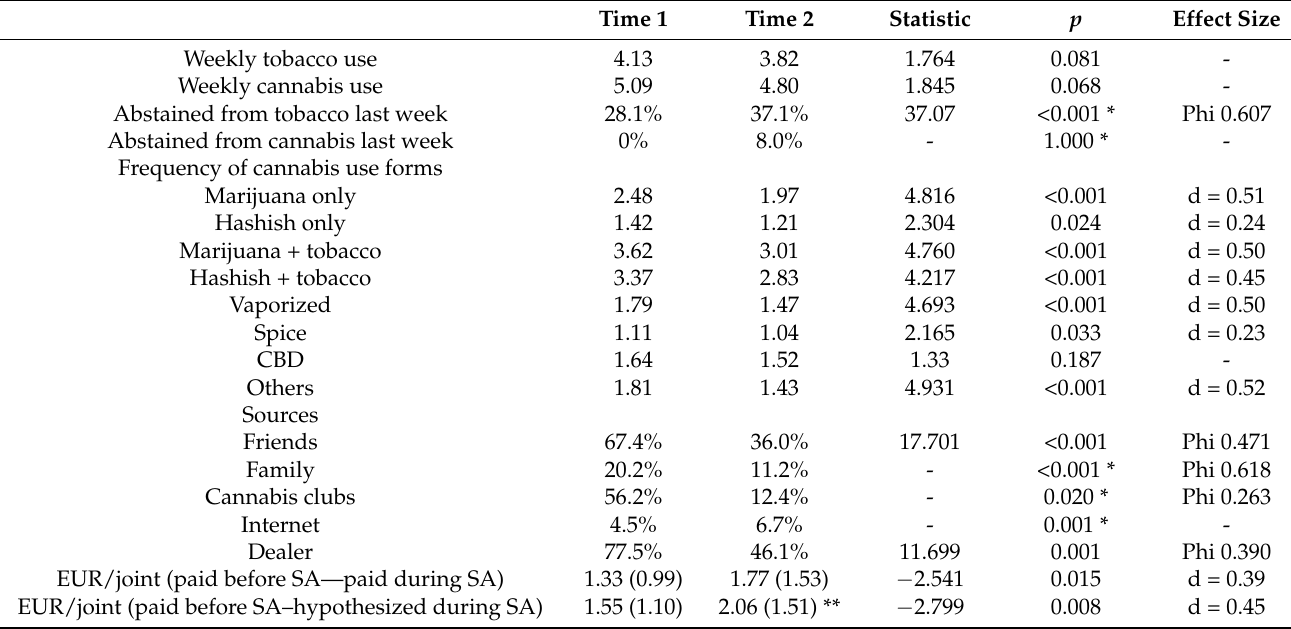
Table 1. Changes in patterns of substance use between Time 1 and Time 2.